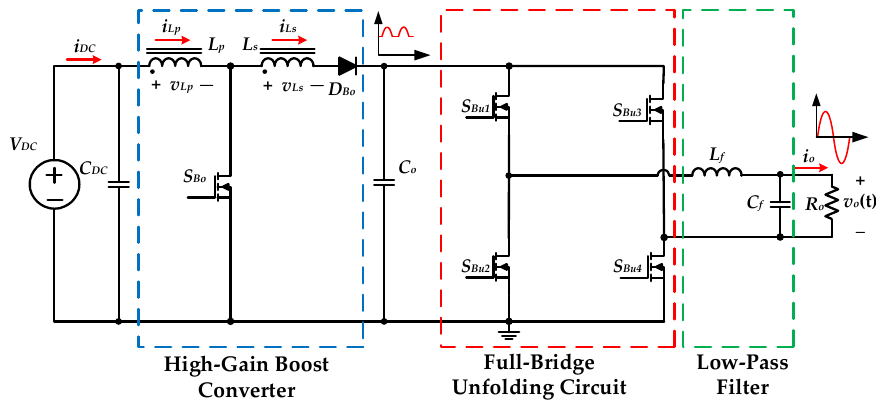
Figure 4. The circuit configuration of the proposed high-gain inverter with magnetic coupling.